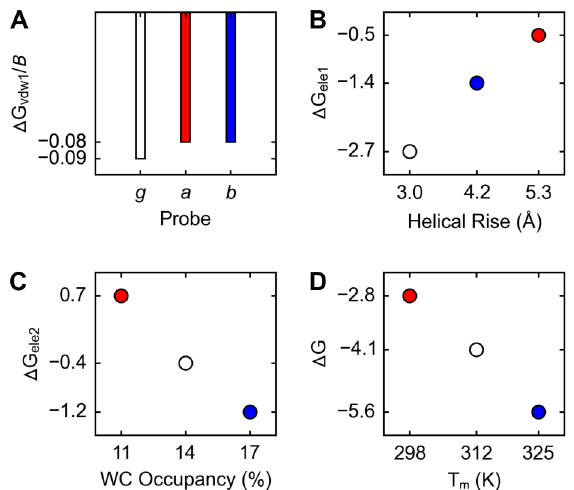
Figure 4. Relationships between molecular structures, free energies (kcal/mol), and melting temperatures of DNA containing Gua ( g , white), α - ( a , red) or β -FAPy-N7-9-hydroxy-AFB 1 ( b , blue) adduct. ( A ) Probe vs. average van der Waals free energy per non-hydrogen probe-atom. ( B ) Helical rise vs contribution of the probe to the electrostatic free energy of dsDNA formation obtained from PMD 1 simulations. ( C ) Average occupancy of the Watson-Crick hydrogen bonds between nucleobases of the base pair 5 vs. contribution of the probe to the electrostatic free energy of dsDNA formation obtained from PMD 2 simulations. ( D ) Melting temperature vs. contribution of the probe to the free energy of dsDNA